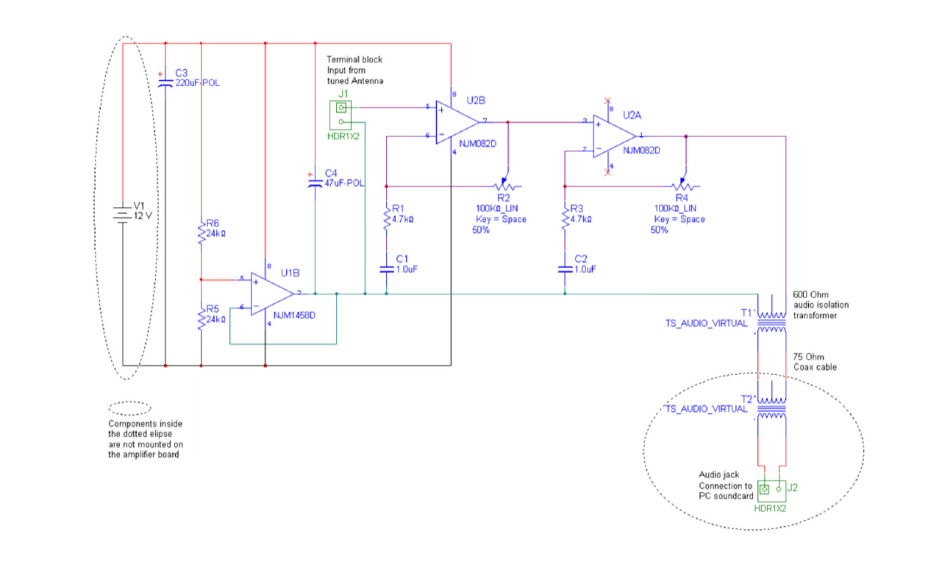
Fig 1: Schematic diagram of amplifier circuit